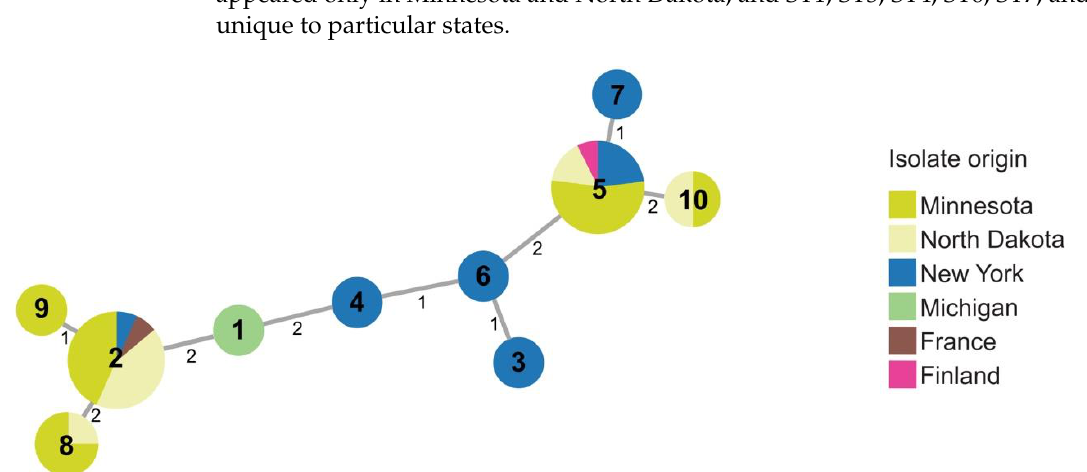
Figure 4. Minimal spanning tree showing relatedness of 39 strains of P. parmentieri including 37 strains obtained in 2015–2016. Each circle represents a sequence type based on concatenated STs from three housekeeping genes ( dnaJ , dnaX , and gyrB ). Sequence type numbers are given in black in each circle. Sizes of circles are relative to the number of individuals sharing the same ST. The relatedness between strains is indicated by relative distance as indicated by branch lengths. Geographic origins of strains are depicted by color: Minnesota (lime green); North Dakota (yellow); New York (blue); Michigan (green); France (brown); Finland (pink).